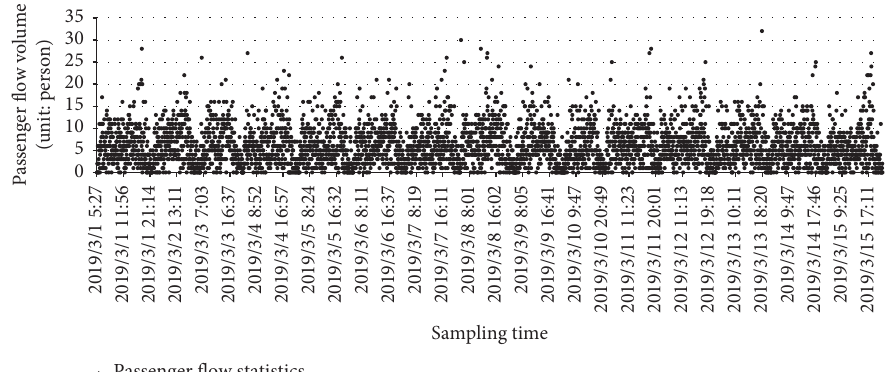
Figure 2: Original passenger flow statistics of station 7 of line 28 within 15